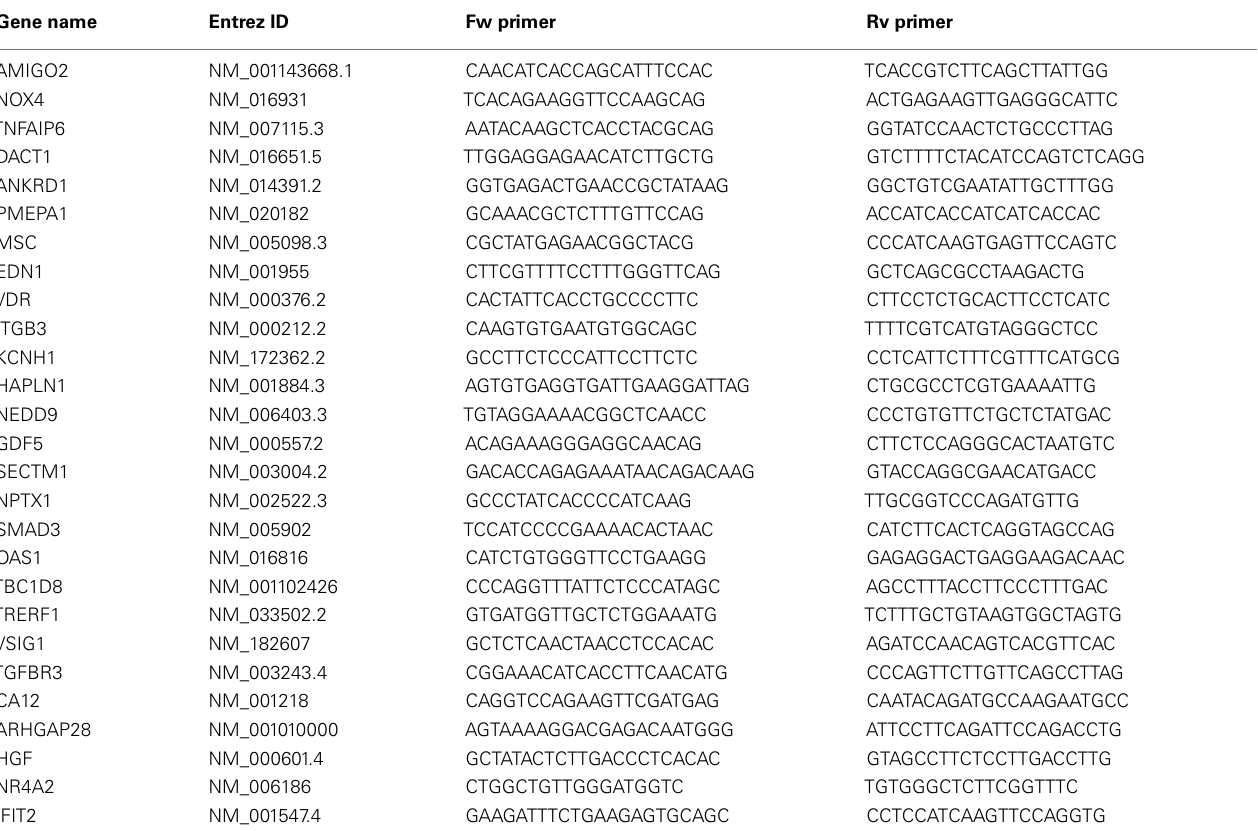
TableA1 | Primers for